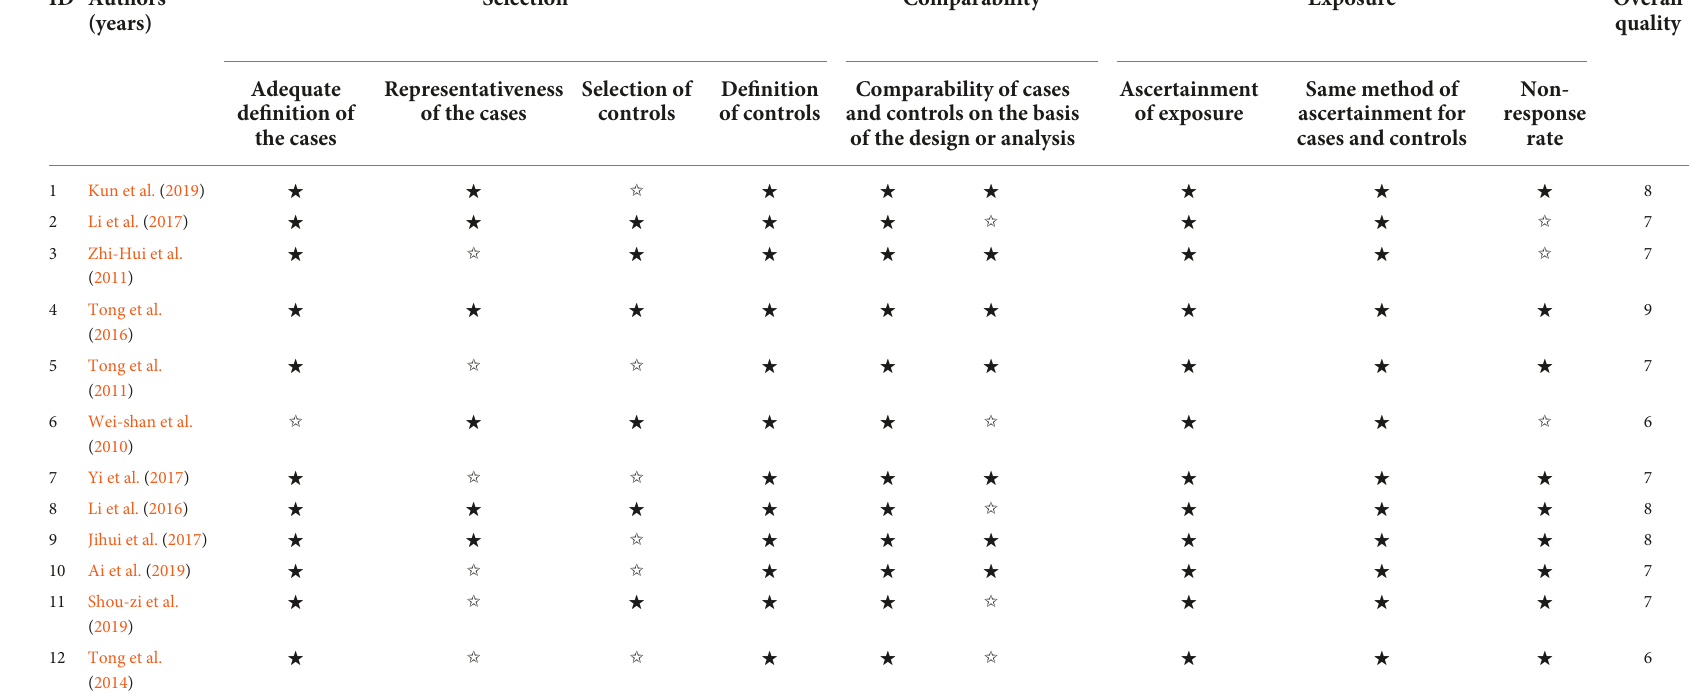
TABLE 1 Quality assessment according to the nine-star Newcastle-Ottawa scale